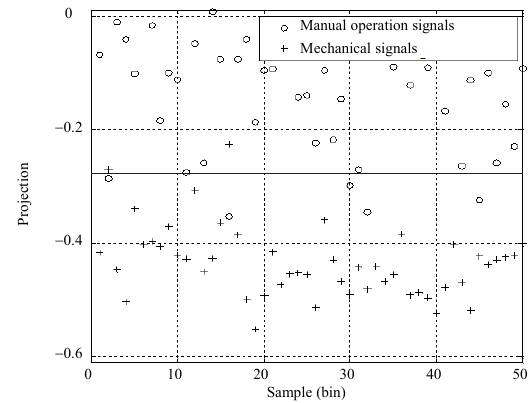
Fig. 11 Classification results of manual operation signals (Sample 3) and mechanical signals (Sample 4).